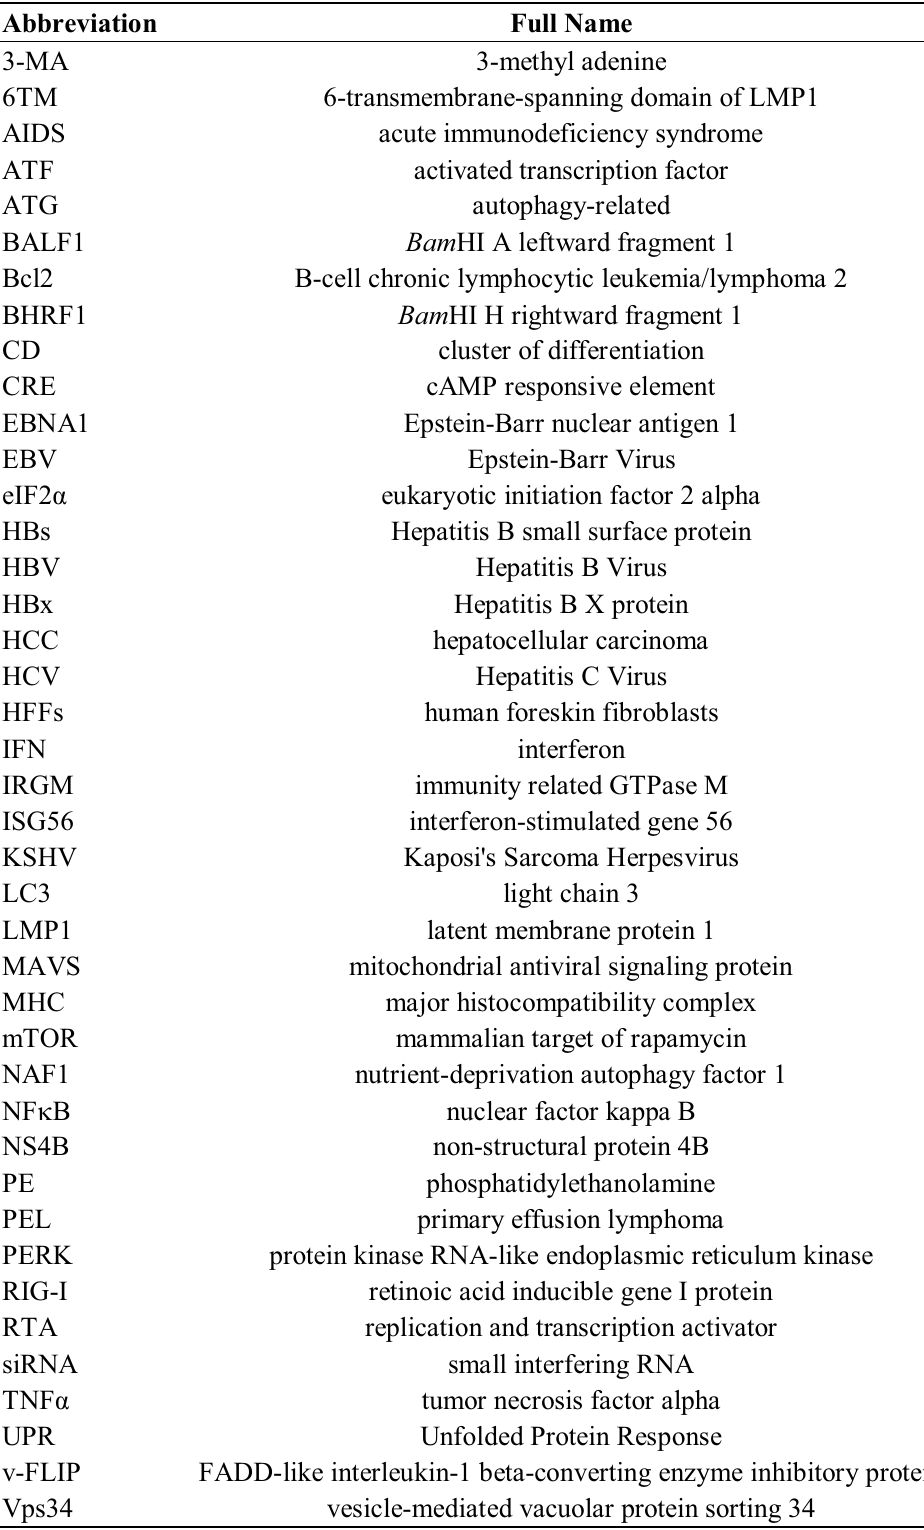
Table 1. Full names of abbreviations used in this